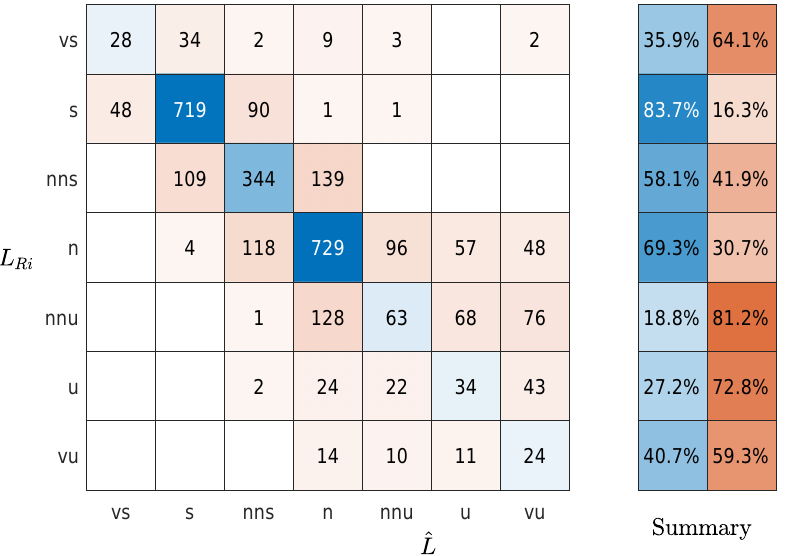
Figure 13. Confusion matrix between ˆ L and L Ri for Gryning’s stability classes (Table 2). The summary matrix on the right totals the HR (bluish) and miss rate (1-HR, reddish) for each stability class. vs, very stable; s, stable; nns, near-neutral stable; n, neutral; nnu, near-neutral unstable; u, unstable; vu, very unstable.